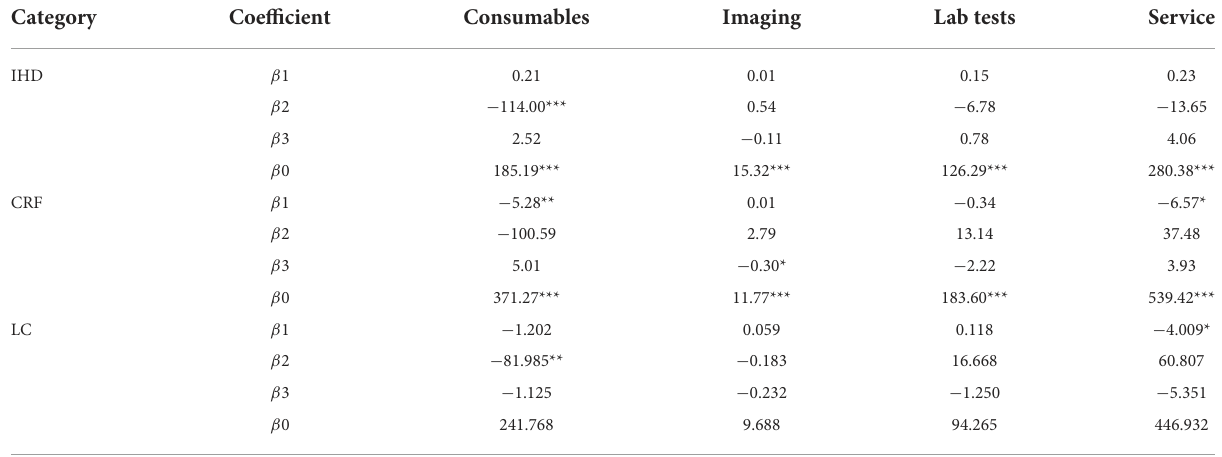
TABLE 5 The impact on the number of inpatients services (ITS model).